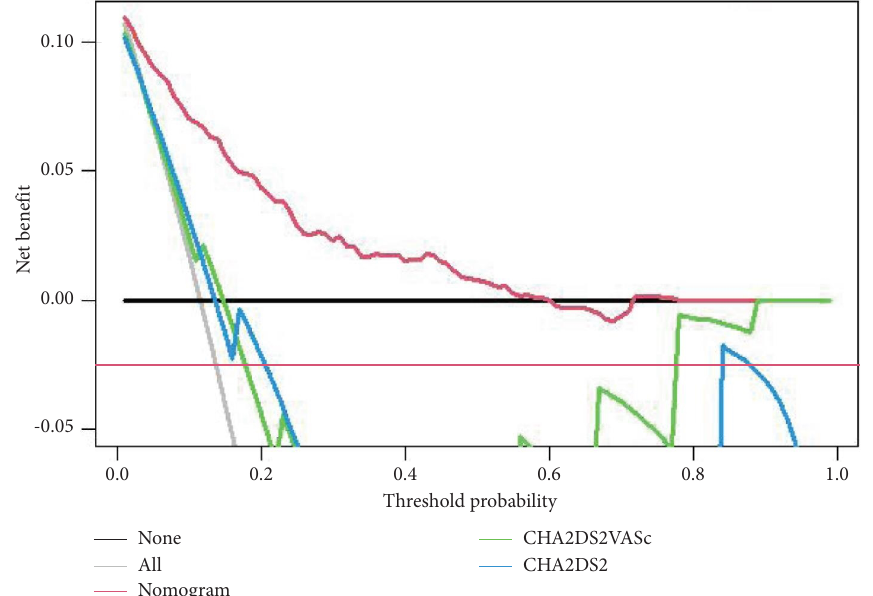
Figure 5: Clinical decision curve analysis of the three scoring